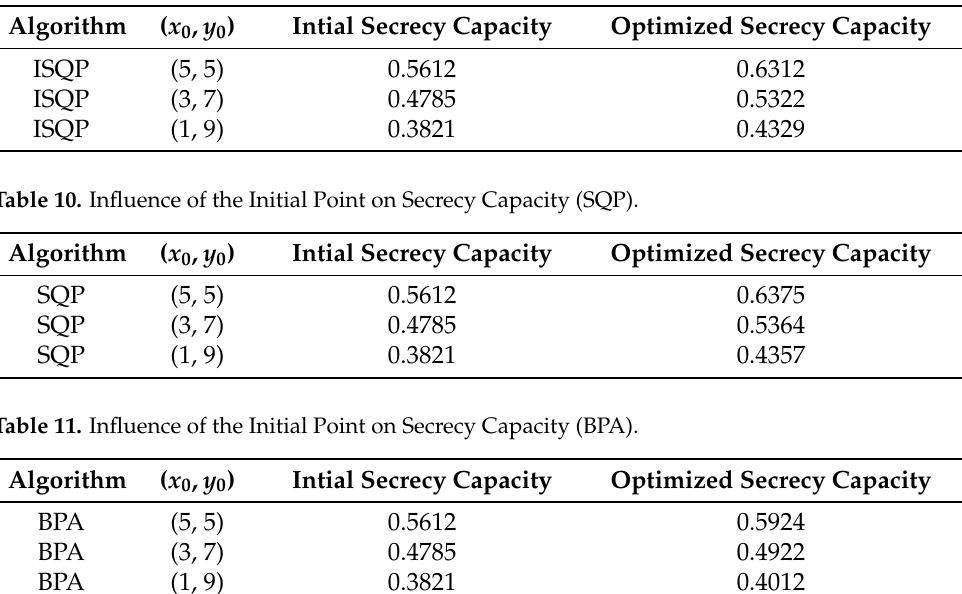
Table 9. Influence of the Initial Point on Secrecy Capacity (ISQP).